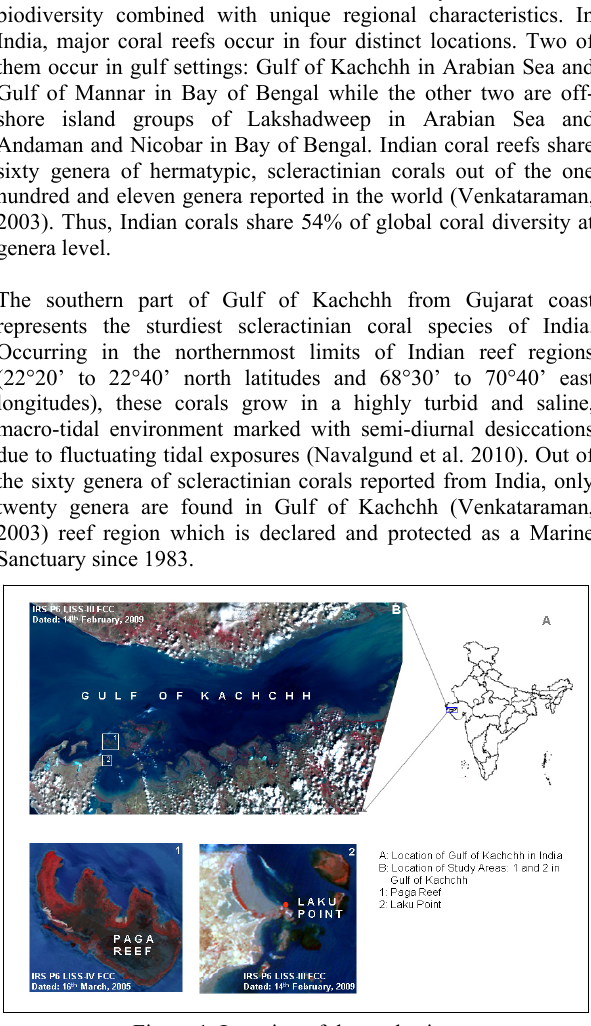
Figure 1. Location of the study